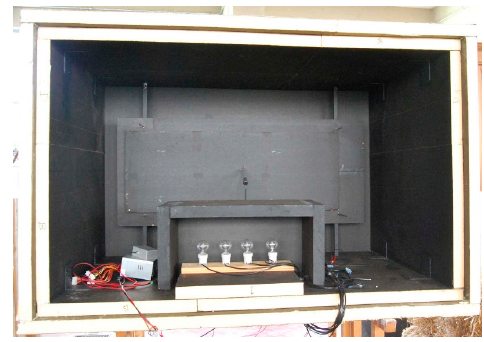
Figure 3. The MC inner back view.